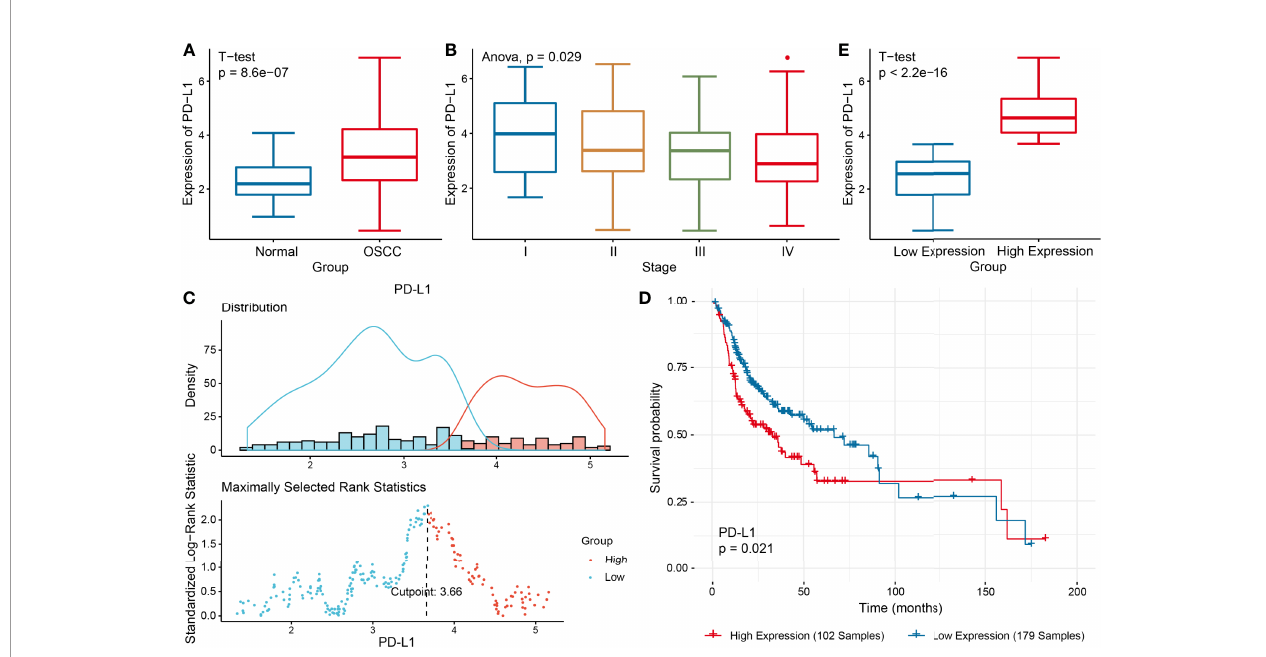
FIGURE 1 | Comprehensive analysis of PD-L1 in OSCC. (A) PD-L1 expression in OSCC group and the control group. (B) PD-L1 expression in different clinical stages of OSCC. (C) The optimal cutoff threshold value (D) Kaplan – Meier survival analysis according to the optimal cutoff value. (E) PD-L1 expression level in different OSCC groups.